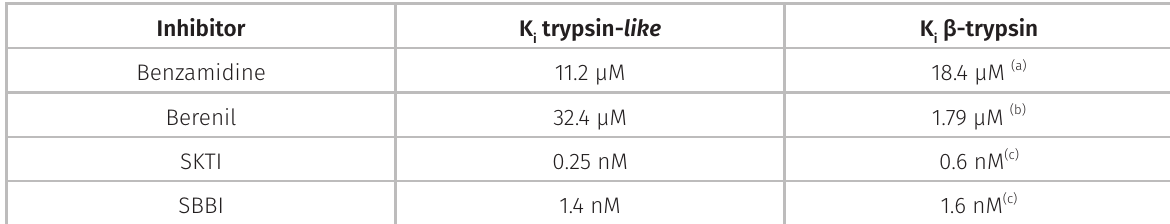
Table III. Inhibition constant of inhibitors of serine proteases of Anticarsia gemmatalis (Lepidoptera: Noctuidae) in the presence of L-BApNA